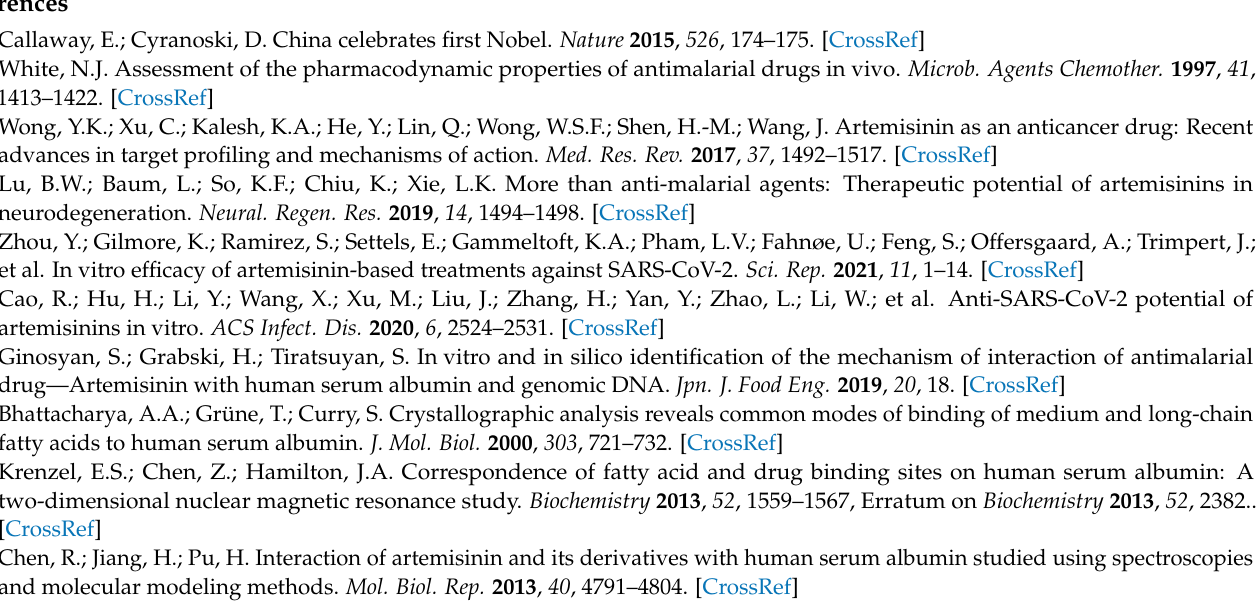
Figure S3: (A) 1 H NMR of 2 mM artemisinin and 1.8 mM of warfarin with 20 µ M of HSA in PBS buffer solution in D 2 O pD 7.4 with 10% DMSO-d 6 . (B) STD NMR of sample A. (C) 1 H NMR of 2 mM DMSO-d 6 . (D) STD NMR of sample C. T = 310, number of scans = 320, and total experimental time = 3 h 30 min. Figure S4: Selective region of 2D Tr-NOESY NMR spectrum (d8 = 300 ms) of 2 mM artemisinin with 20 µ M HSA after the addition of 2 mM warfarin in PBS buffer solution in D 2 O, pD 7.4 with 10% DMSO-d 6 . (A) Red cross-peaks correspond to inter-NOEs between warfarin and artemisinin and (B) blue cross-peaks correspond to intra-NOEs of artemisinin. Mixing time = 300